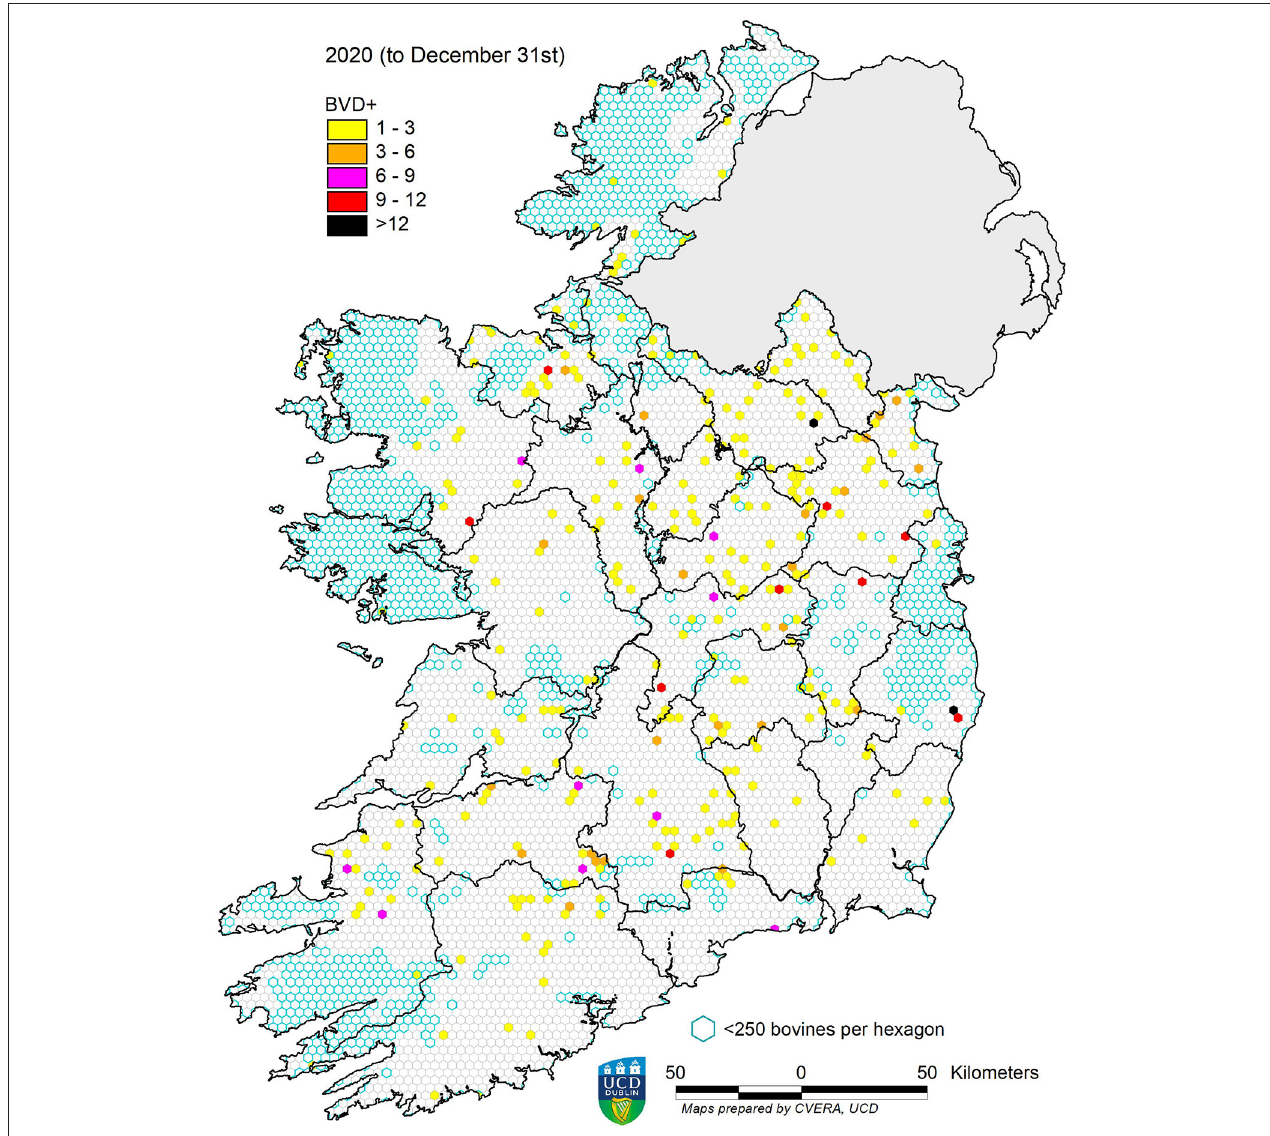
FIGURE 6 | Distribution of BVD + calves born in 2020. Each hexagon ∼ 10 km 2